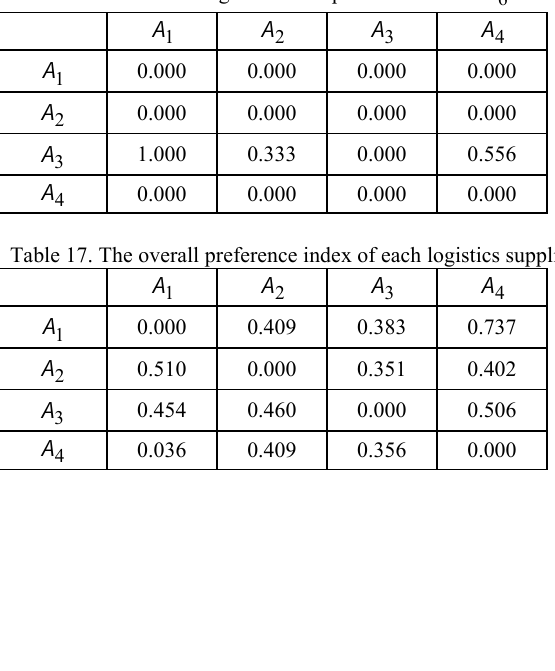
Table 11. Preference degree with respect to criterion 1 C